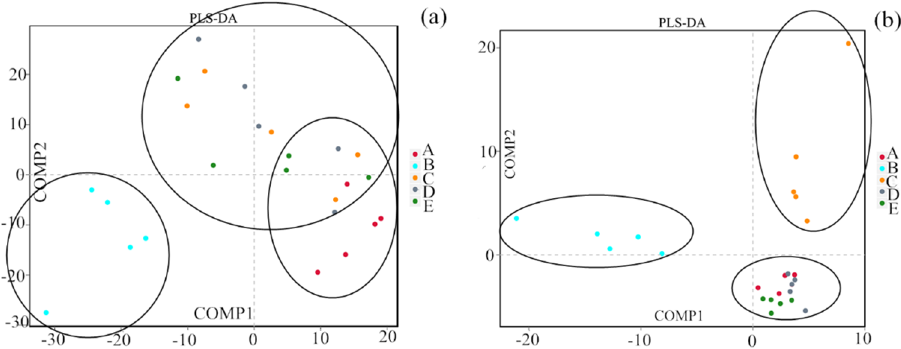
Figure 2. Partial least squares discriminant analysis (PLS-DA) of the bacterial ( a ) and fungal ( b ) community compositions among the different treatments. A indicates 0% (NC), B indicates 20% (LIC), C indicates 40% (MIC 1 ), D indicates 60% (MIC 2 ) and E indicates 80% (HIC).